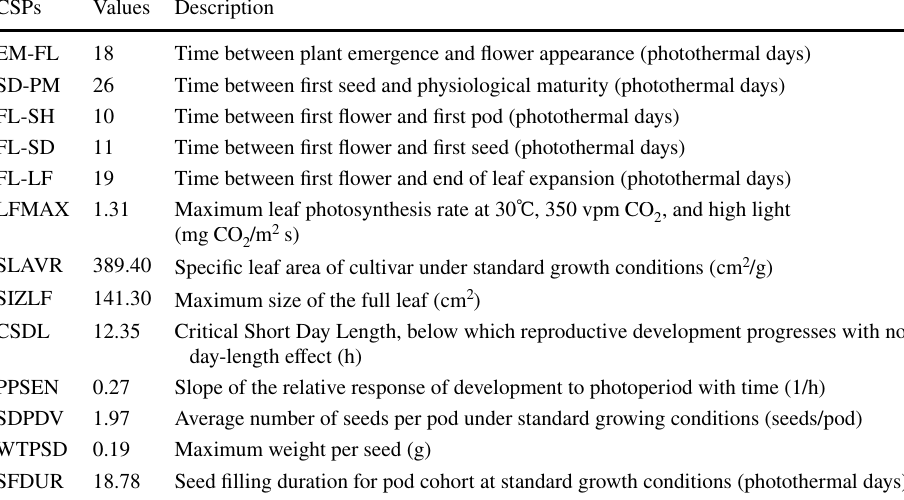
Table 7 Absolute relative error (ARE) between simulation and observation results in the Huaibei Plain study area in Anhui Province, China